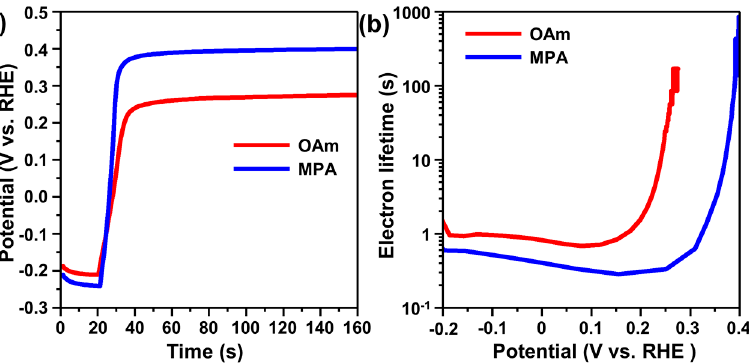
Figure 5. ( a ) OCVD curves and ( b ) electron lifetime as a function of V OC for OAm-QD-photoanode and MPA-QD-photoanode.